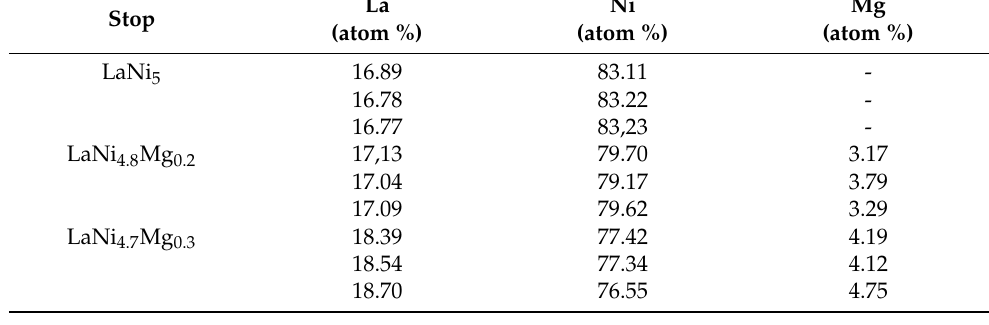
Table 1. Measurement results for chemical composition of LaNi 5-x Mg x (x = 0, 0.2, and 0.3).